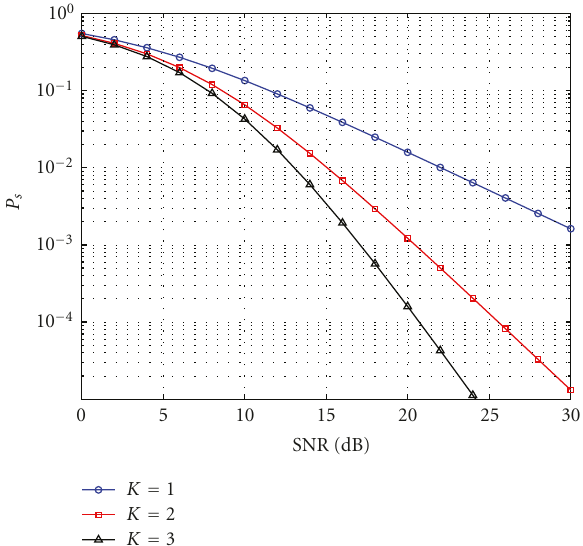
Figure 5: Average symbol error probability versus average SNR per bit for 16-QAM signals with di ff erent SNR values at each diversity branch, m = 1,0 . 5,3 for K = 1,2,3, respectively.